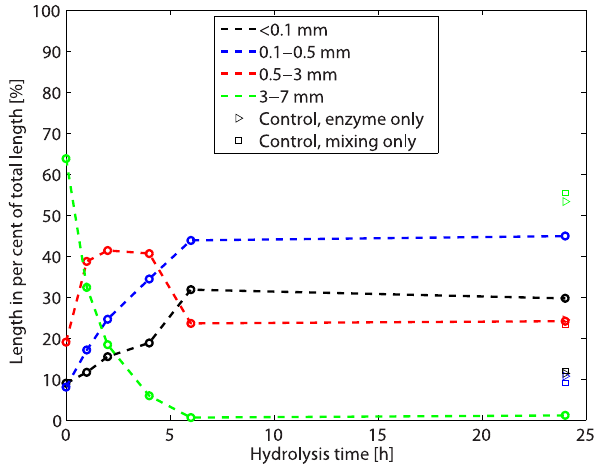
Figure 2. Actual fibre length distributions for flax during enzymatic